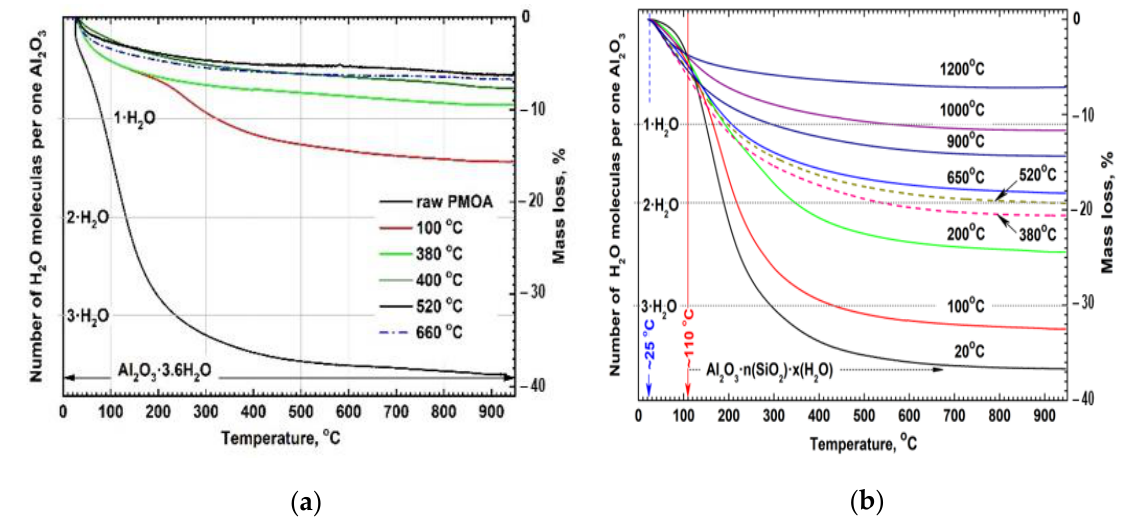
Figure 2. Molecular ratio H 2 O/Al 2 O 3 and relative mass loss for: ( a ) monolithic raw PMOA sample and the samples pre-annealed at the fixed temperature and cooled down in humid air (except the powder sample PMOA pre-annealed at 660 °C) [11]; ( b ) monolithic PMOA-M sample and the samples pre-annealed at the fixed temperature and cooled down in humid air. From the comparison of the mass loss curves, it follows that a noticeable dehydration of the PMOA-M samples begins at the temperatures ≥ 110 °C and almost immediately upon heating for the PMOA samples without chemical surface modification.